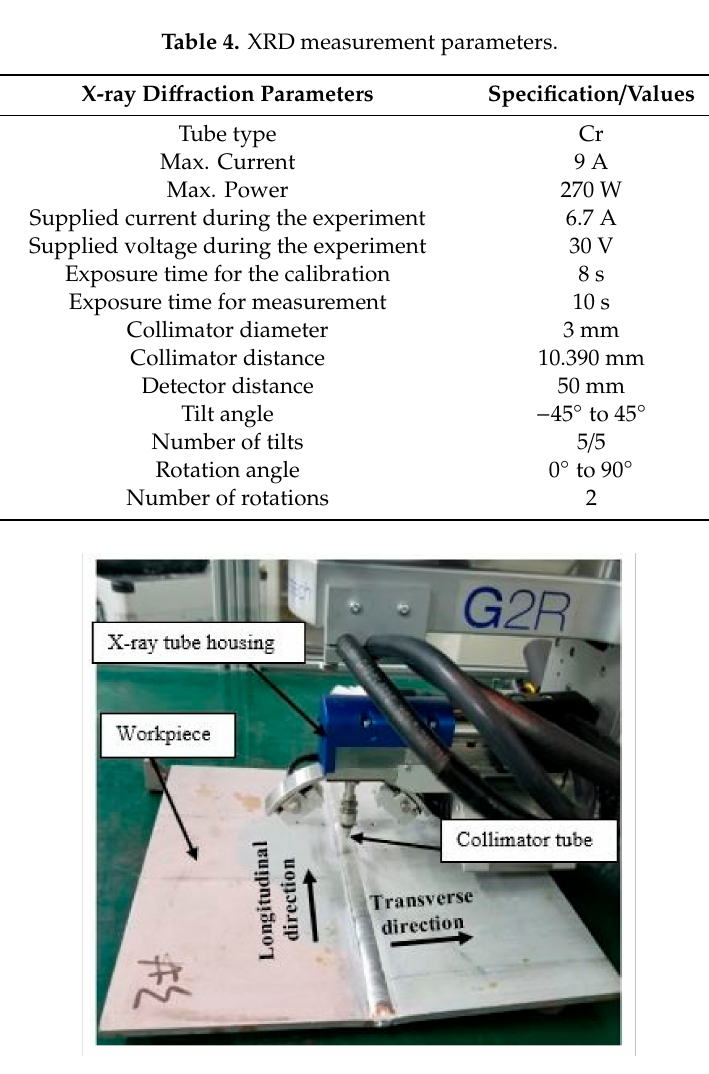
Figure 8. Residual stress measurement using